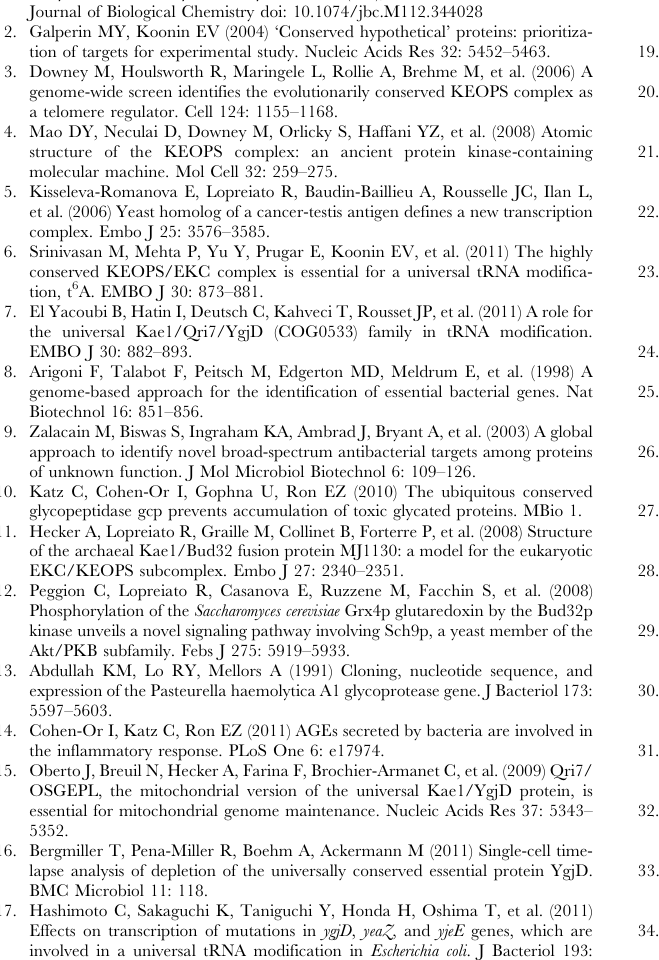
Table S1 Plasmids used in this study. Table S2 Oligonucleotides used in this